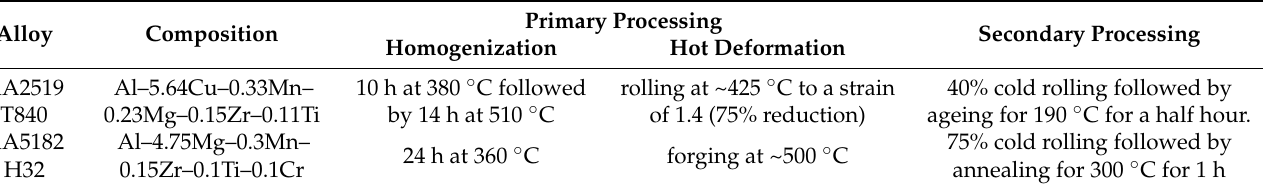
Table 1. Compositions and thermomechanical treatments of the studied alloys.